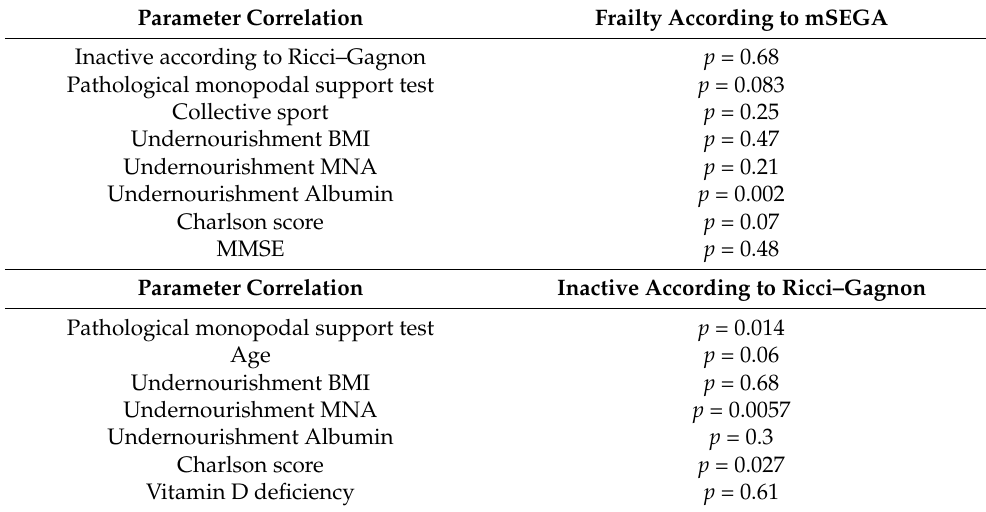
Table 3. Summary of correlations frailty syndrome and inactive profile according to Ricci–Gagnon. Parameter Correlation Frailty According to mSEGA Inactive according to Ricci–Gagnon p = 0.68 Pathological monopodal support test p = 0.083 Collective sport p = 0.25 Undernourishment BMI